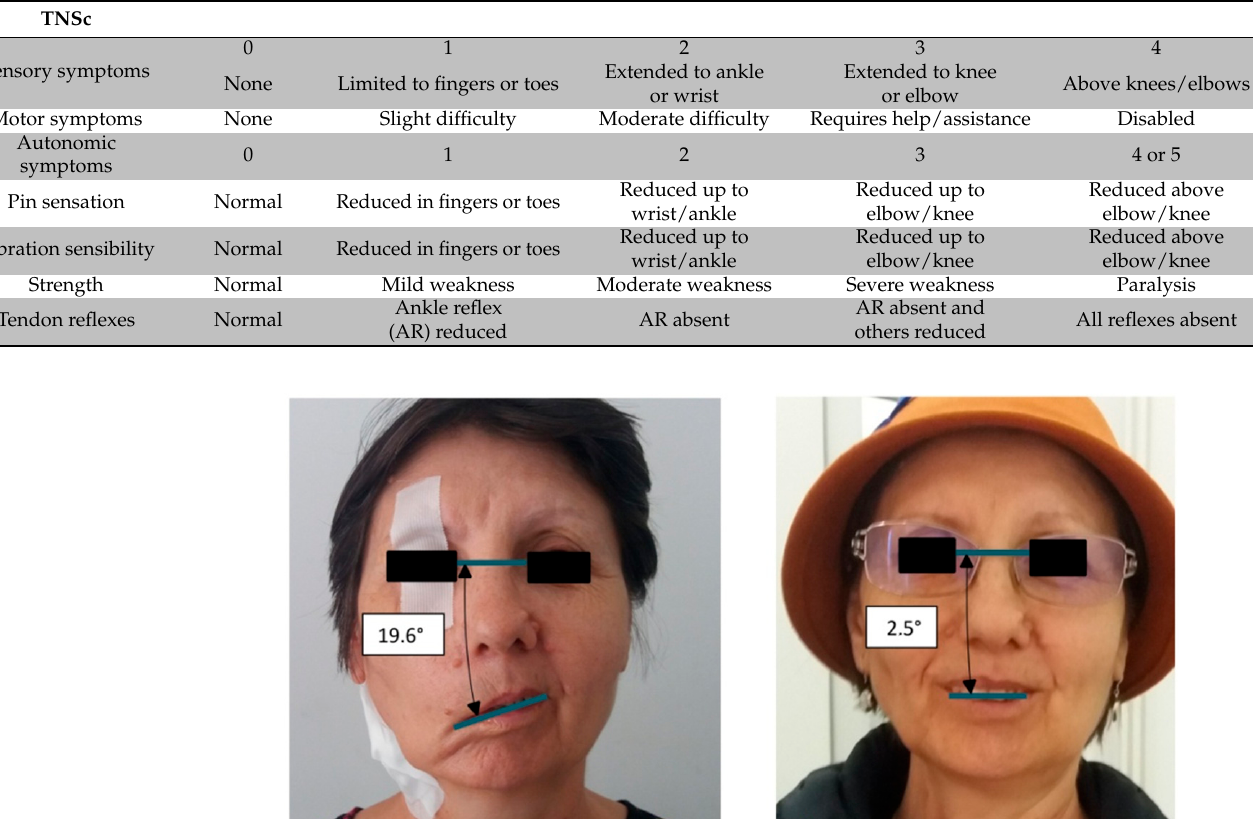
An angle of 0 ◦ represents perfect